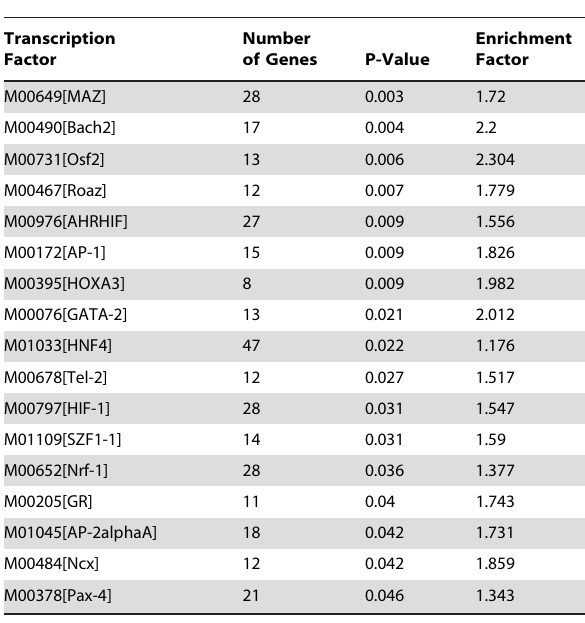
Table 5. Transcription factor binding sites enriched in gene promoters of differentially expressed mRNAs that are targets of differentially expressed microRNAs in PND1